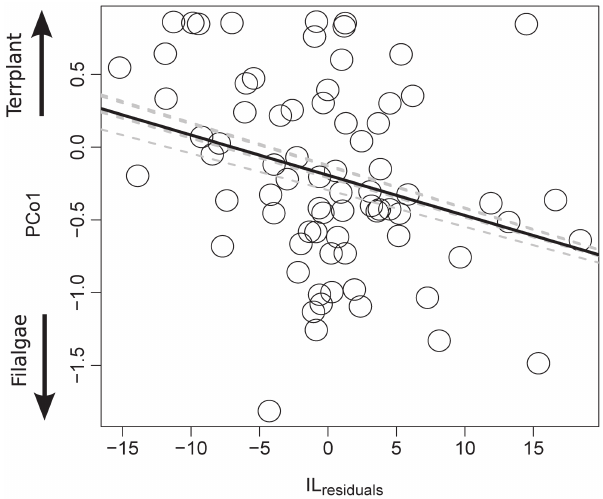
Fig. 5. Relationships between diet composition of Deuterodon stigmaturus summarized by the PCo1 of a Principal Coordinate Analysis (PCoA) and intestine length independent of standard length (IL ). Higher PCo1 residuals values indicate a greater proportion of terrestrial plants (Terrplant) and lower values indicate a greater proportion of filamentous algae (Filalgae). Sampling months (dashed lines) were used as random effect variable and IL residuals was used as a fixed effect (solid line) variable to fit a linear mixed-effects model.